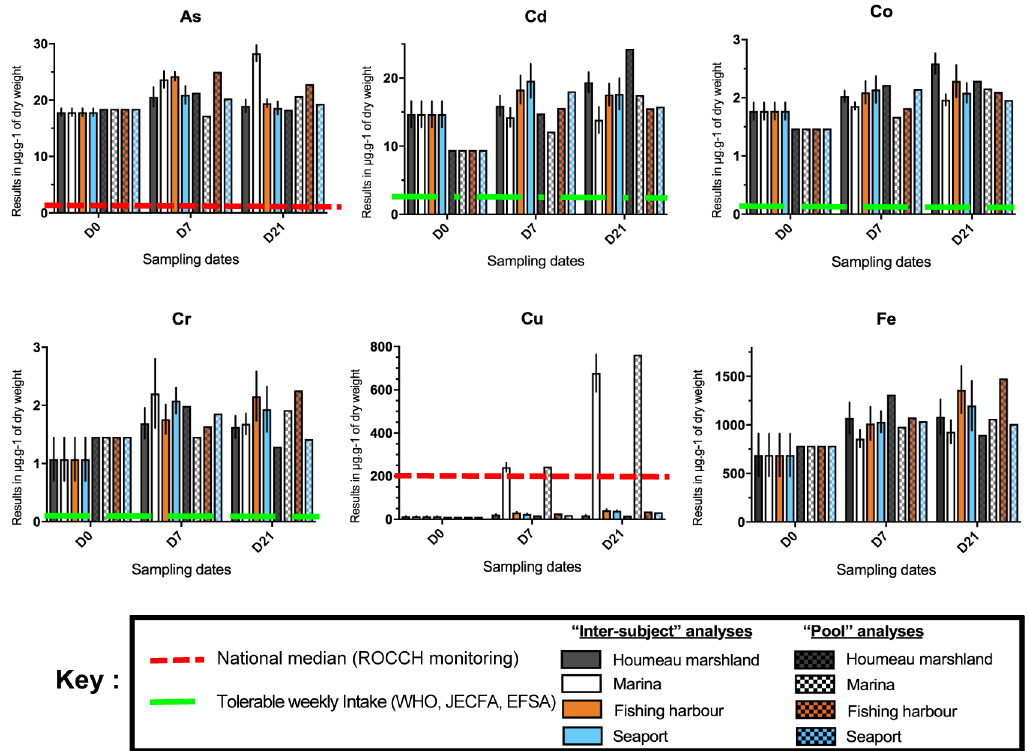
Fig 3. Heavy metals (As, Cd, Co, Cr, Cu, Fe) in the digestive glands of black scallops M . varia assessed for all sites (the marshland, the marina, the fishing harbour and the seaport) in 2017 at three sampling dates (D0, D7 and D21). These graphs indicate both “inter-subject” (n = 7/site/sampling) and “pool”